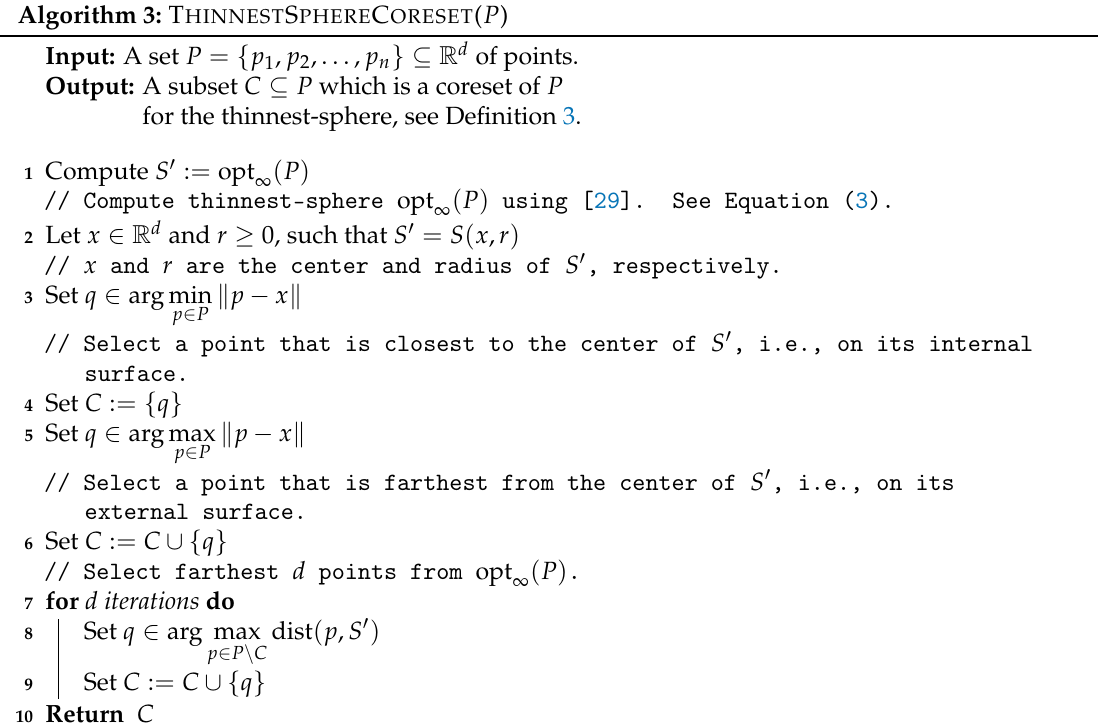
Algorithm 3: T HINNEST S PHERE C ORESET ( P